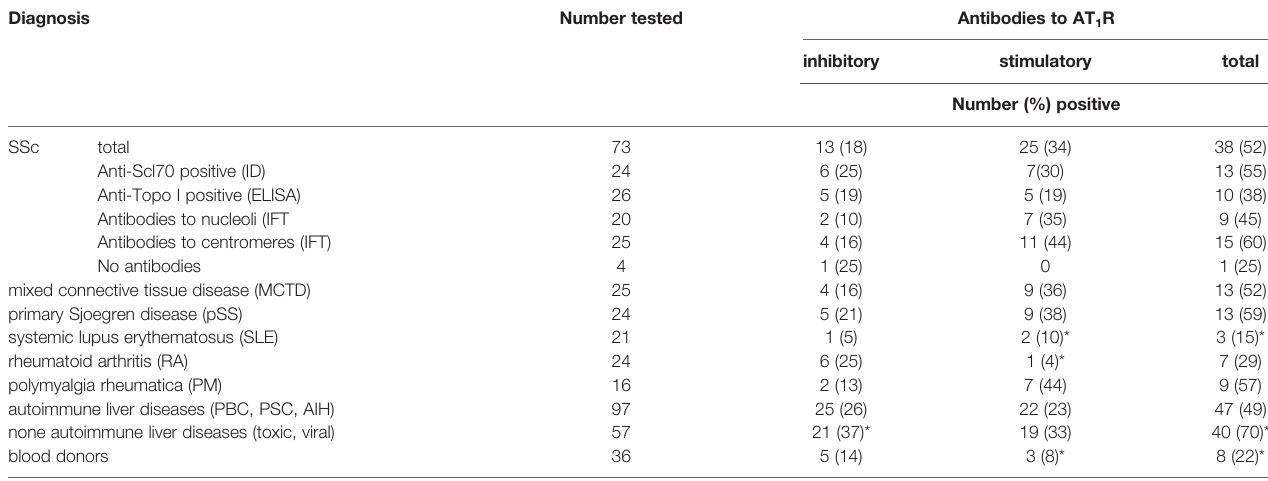
TABLE 1 | Prevalence of stimulatory and inhibitory antibodies to the AT 1 R in immunoglobulins from patients with different disorders as measured by a luminometric assay.